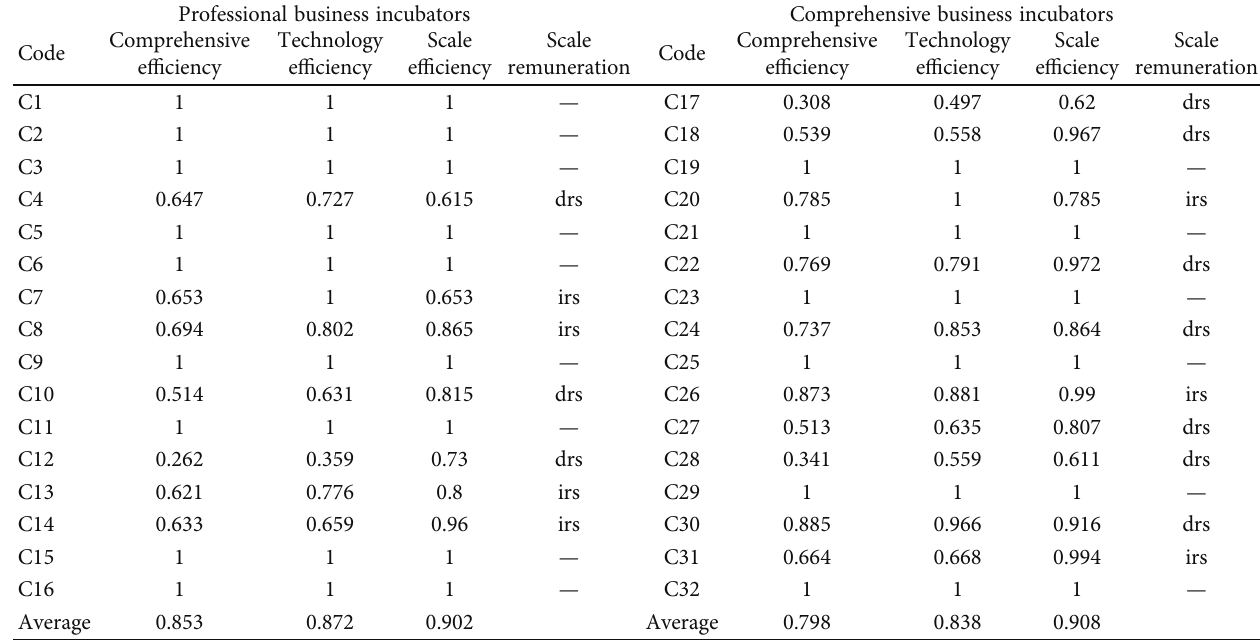
Professional business